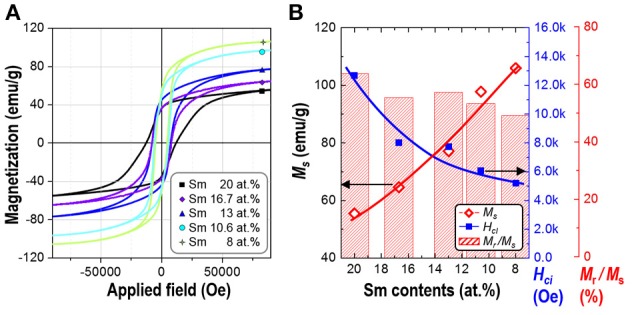
(A) Magnetic hysteresis loops and (B) the change of saturation magnetization (Ms), squareness (Mr/Ms), and intrinsic coercivity (Hci) of synthesized Sm-Co fiber with different Sm contents (at.%).